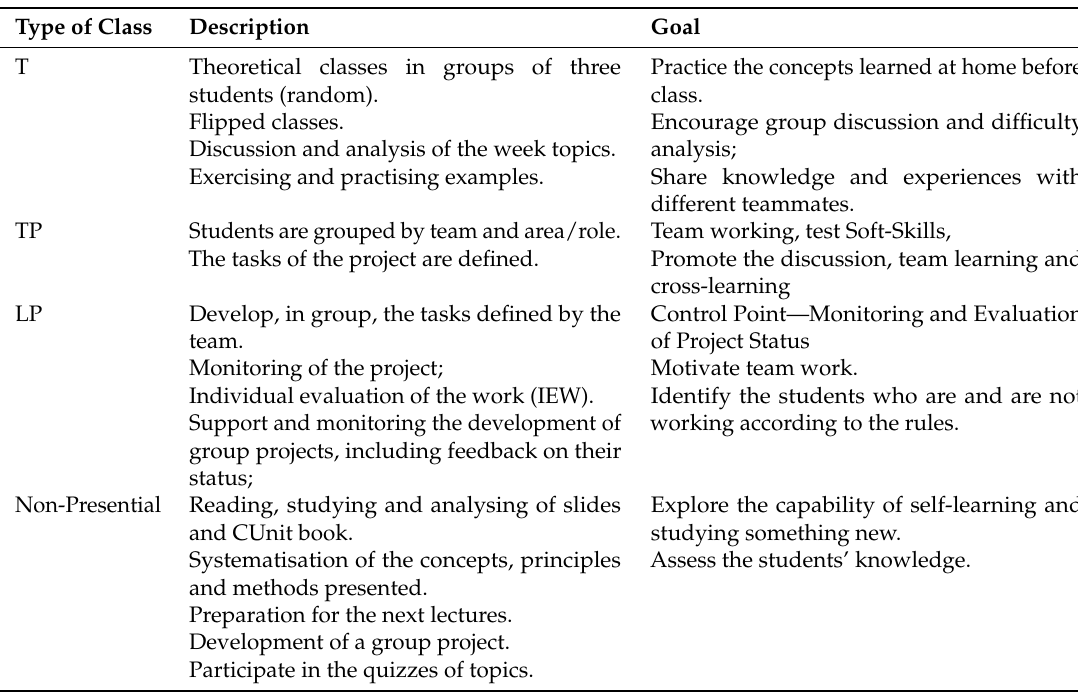
Table 6. Description and goal of each